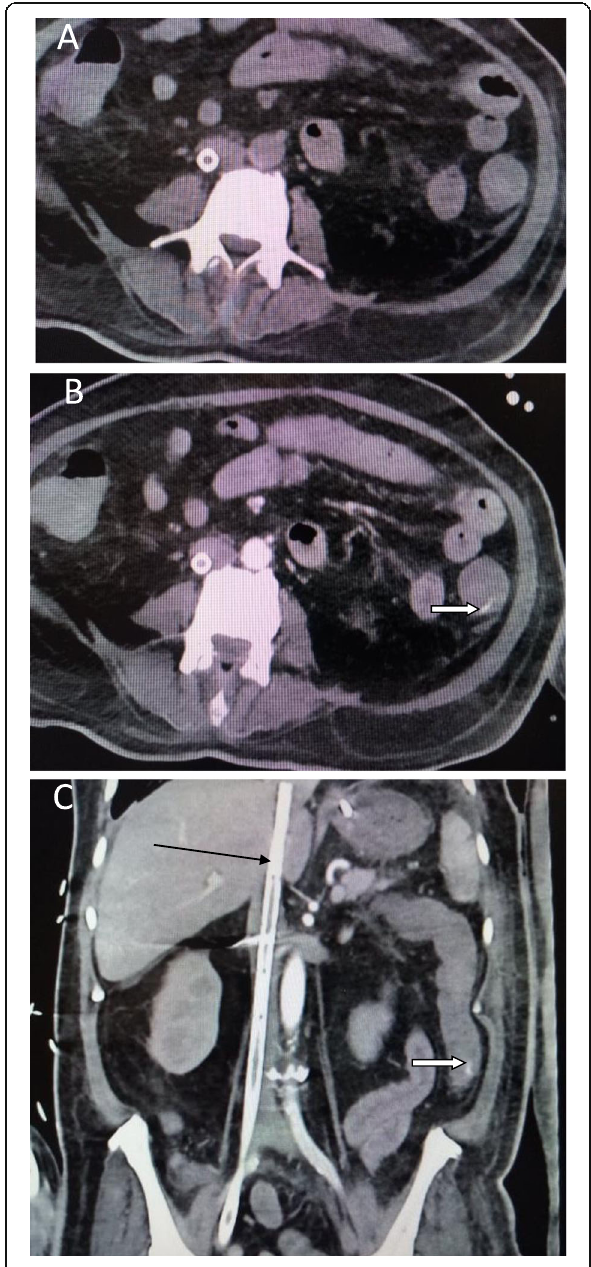
Fig. 6 Fifty-six-year-old COVID-19 male patient isolated in the ICU due to respiratory failure with past medical history of DM and HTN then presented with hematochezia. MDCT study was done: a axial non contrast scan of CT of the abdomen and b post contrast axial scans in the arterial phase showing active contrast extravasation in the lumen of the descending colon (open arrow). c Coronal